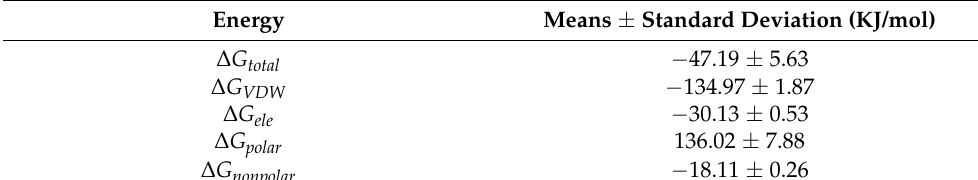
Table 1. The binding energy between PFO and piceatannol.